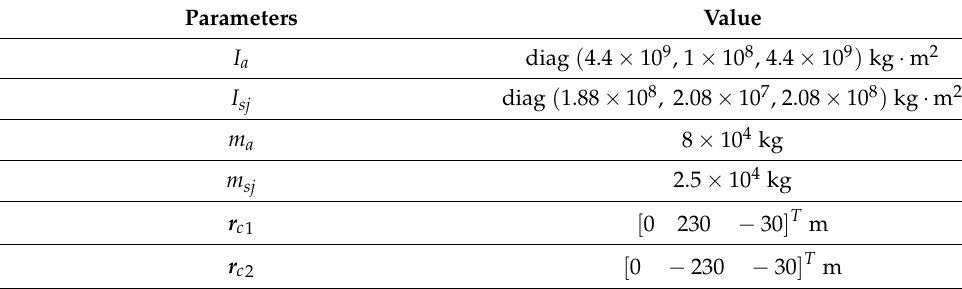
Table 1. Parameters of the MR-SPS.